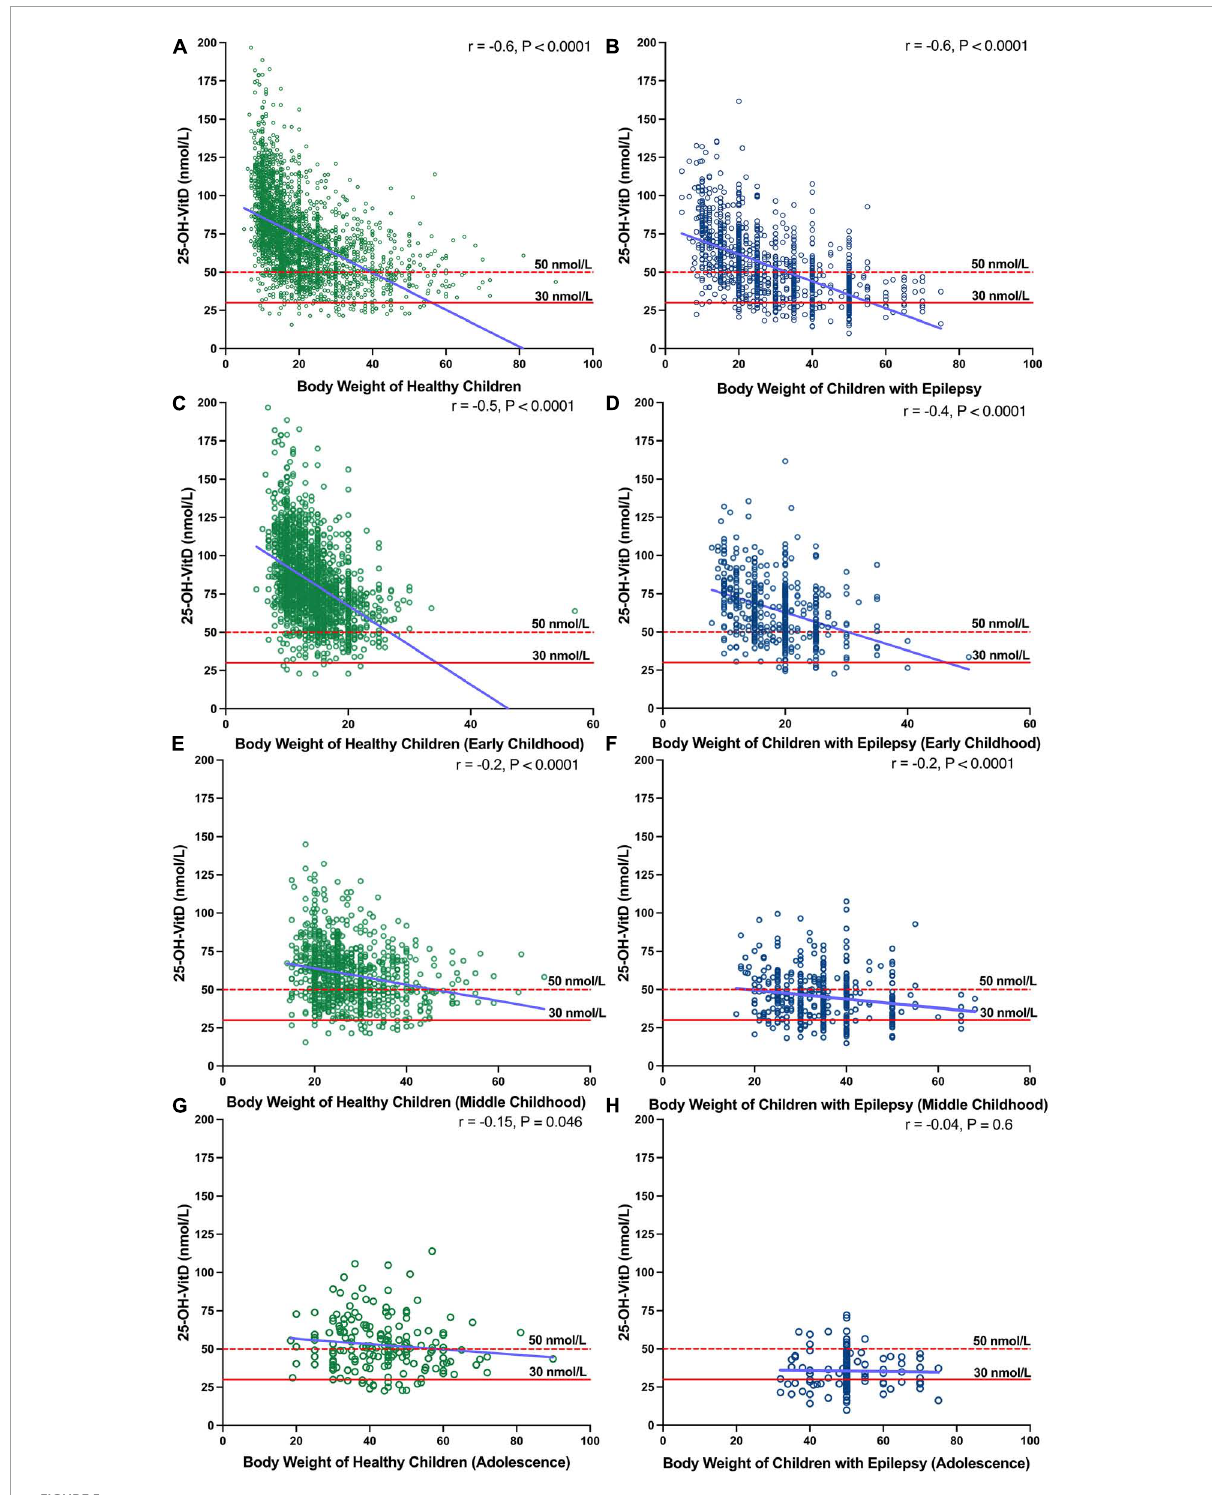
FIGURE5 Association between BW and serum 25-OH-VitD status in healthy subjects and epileptic subjects with different ages (Early Childhood, Middle Childhood, and Adolescence). (A) Association between BW and serum 25-OH-VitD status in healthy subjects. (B) Association between BW and serum 25-OH-VitD status in epileptic subjects. (C) Association Early childhood in healthy children. (D) Early childhood in children with epilepsy. (E) Middle childhood in healthy children. (F) Middle childhood in children with epilepsy. (G) Adolescence in healthy children. (H) Adolescence in children with